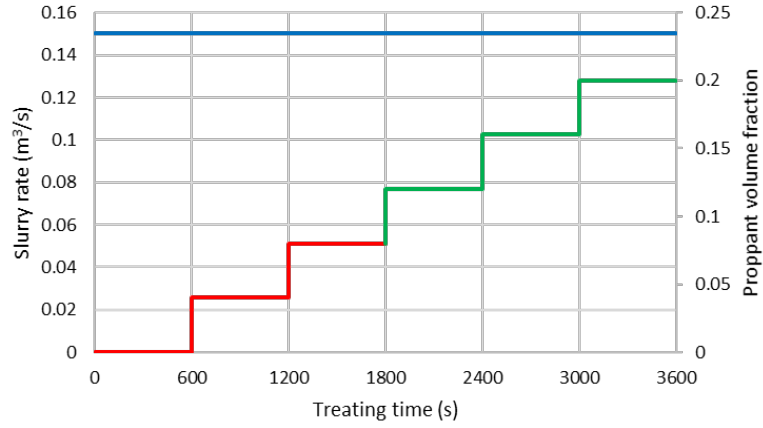
Figure 8. Treatment schedule of the hydraulic fracturing job.